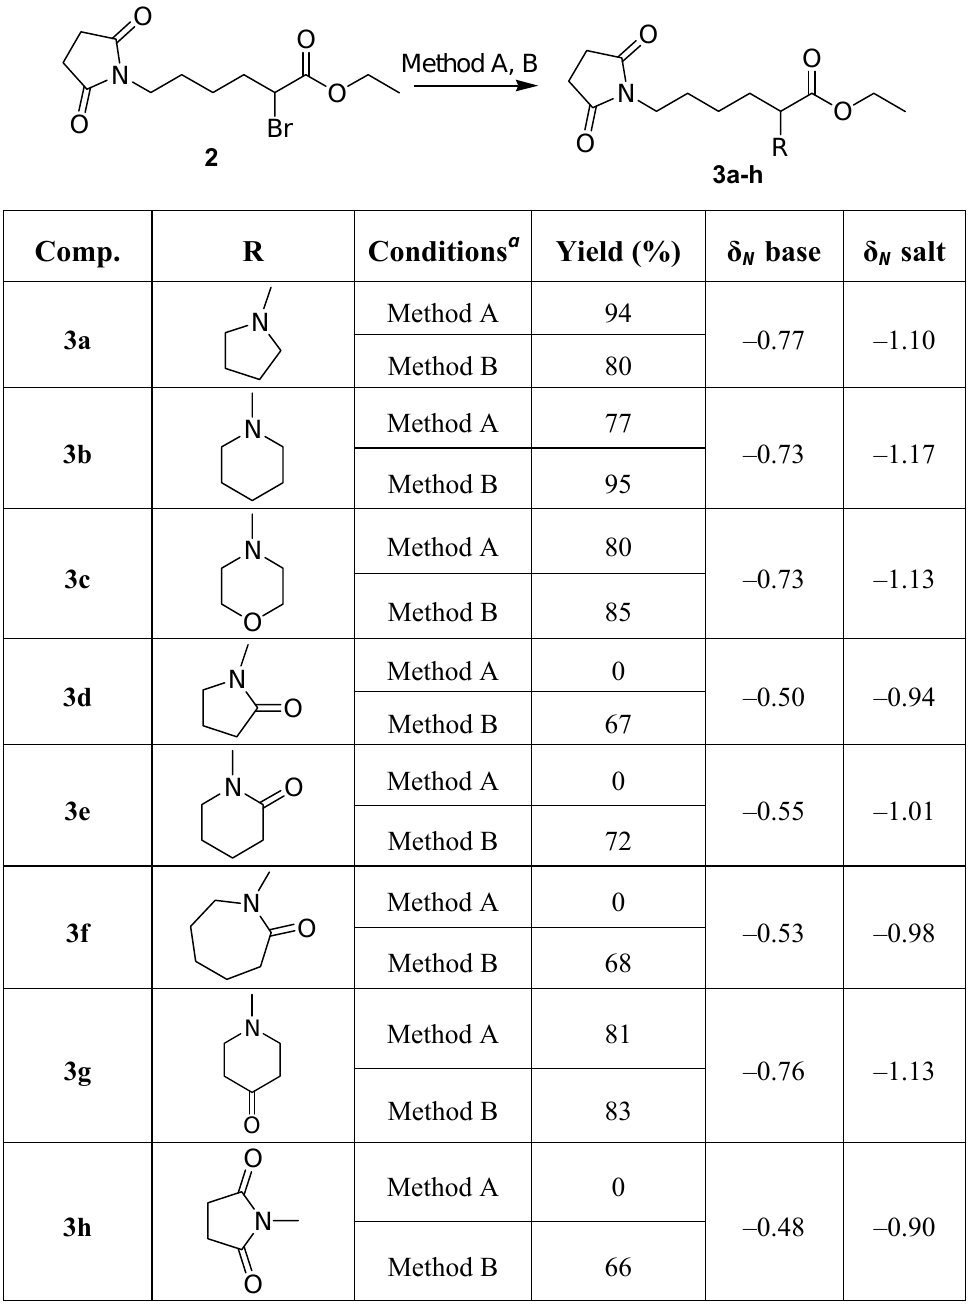
) of the free bases in toluene or the N